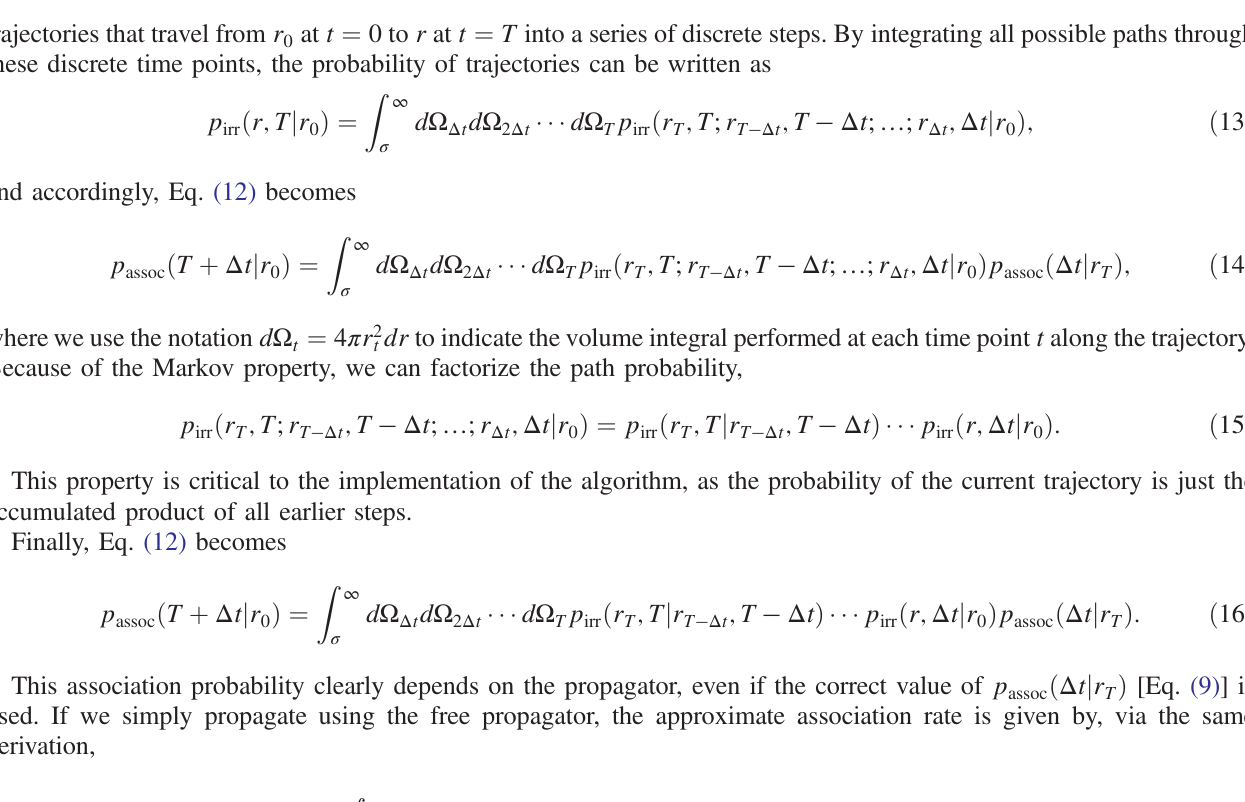
FIG. 2. Green ’ s function for a pair of particles being propagated using Eq. (7) (dark solid lines) and propagated using Eq. (11) (blue dashed lines) with trajectory reweighting. Each curve represents the particle distribution after another time step, top to bottom at r ¼ σ , with particles initially placed close to contact at r 0 ¼ σ þ 0 . 05 nm. (a) k a ¼ 0 . 1 nm 3 = μ s, D AB ¼ 5 nm 2 = μ s, and Δ t ¼ 0 . 1 μ s. (b) k a ¼ ∞ , D AB ¼ 20 nm 2 = μ s, and Δ t ¼ 0 . 1 μ s. The deviations between the exact and the free propagators varies depending on the reaction parameters. The FPR algorithm uses trajectory reweighting to recover the association rates that would result if positions were sampled using the exact